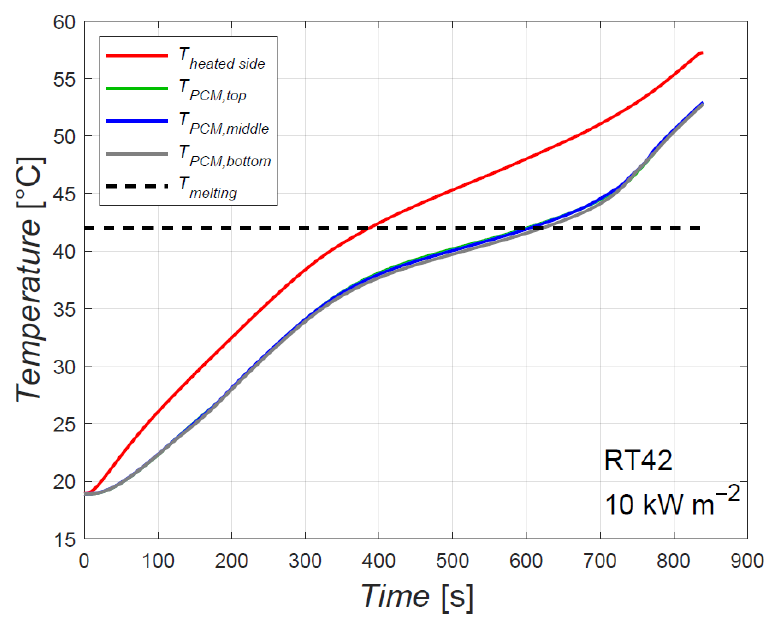
Figure 5. Temperature profiles for the paraffin RT42 with an imposed heat flux of 10 kW m − 2 . Table 3. Summary of the experimental